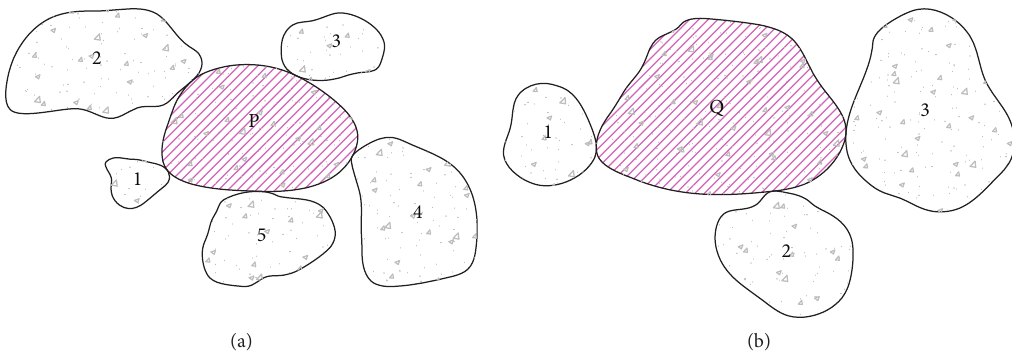
Figure 3: Diagram of coarse aggregate coordination number: (a) stable particle P and (b) unstable particle